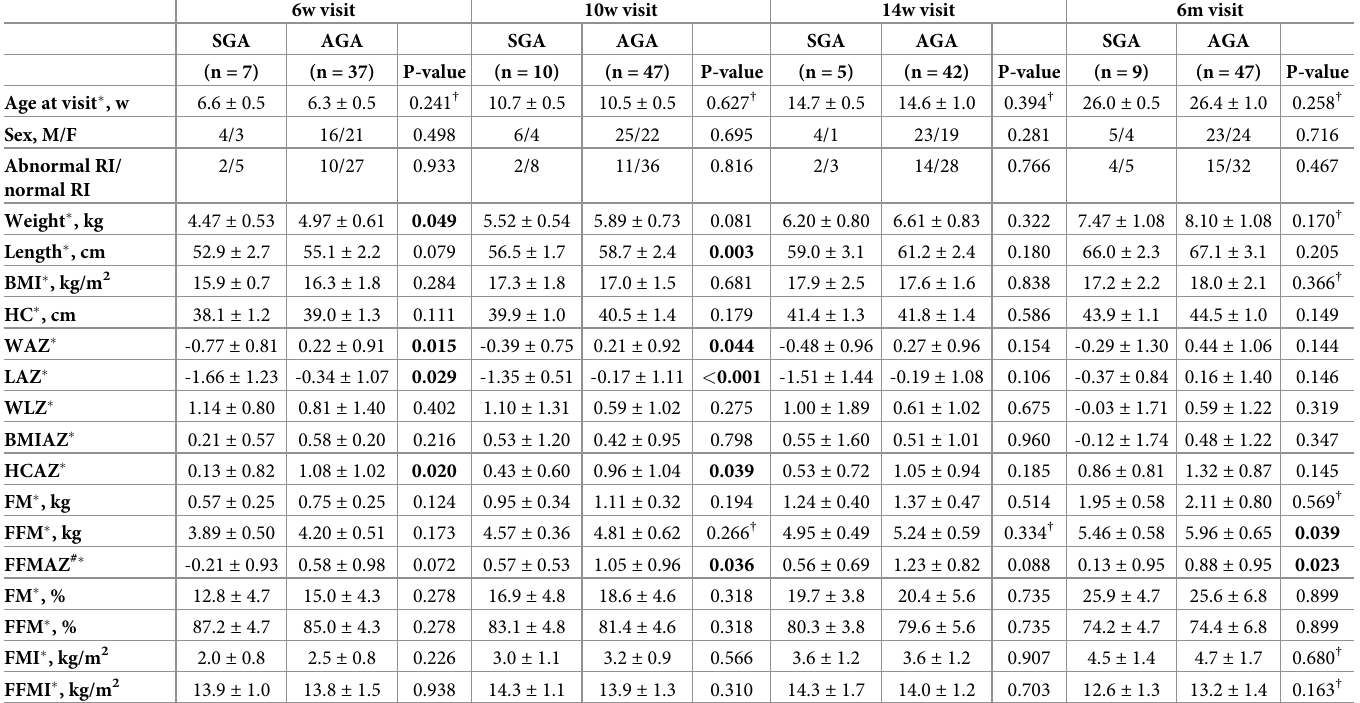
Table 3. Anthropometric and body composition data at child follow-up visits, as grouped by birth weight categorization into small-for-gestational age and appro- priate-for-gestational age.